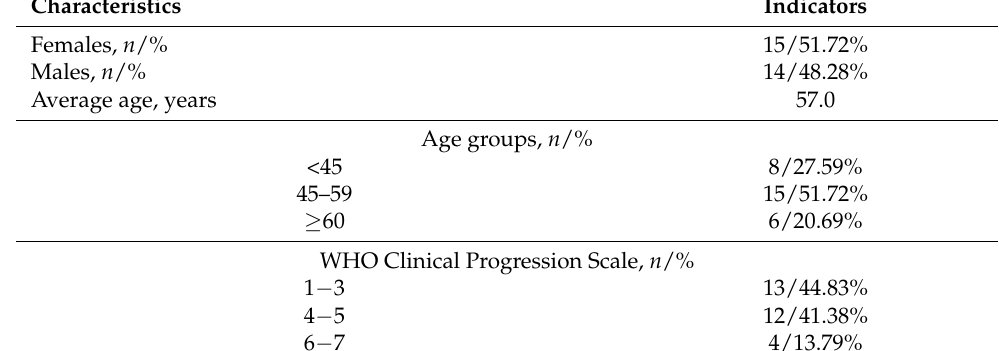
Table 7. Clinical and demographic characteristics of examined patients with post-COVID syndrome.